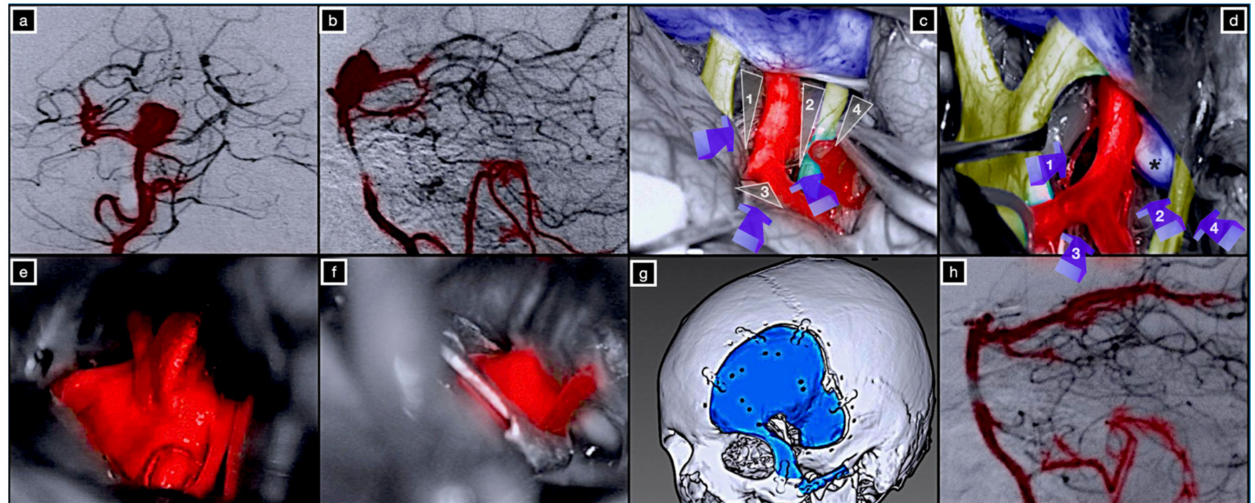
Figure 7. Preoperative digital subtraction angiography of the right vertebral artery in anterior– posterior ( a ) and lateral ( b ) projection. ( c , d ) Intraoperative pictures showing the right optic-carotid (1), carotid-oculomotor (2), supracarotid (3), and oculomotor-tentorial (4) deep windows * posterior clinoid process. Exposure ( e ) and clip ligation ( f ) of the basilar tip aneurysm. ( g ) Three-dimensional (3D) volume-rendered postoperative CT scan highlighting the COZ approach. ( h ) Postoperative digital subtraction angiography of the right vertebral artery in lateral